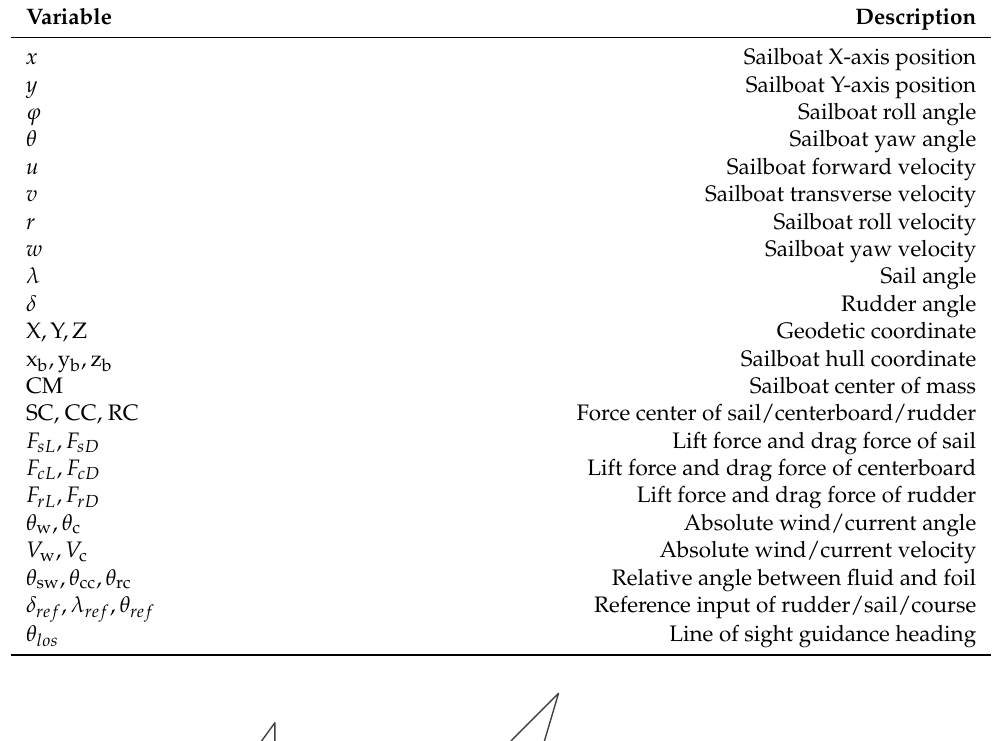
Table 1. Variable definitions.